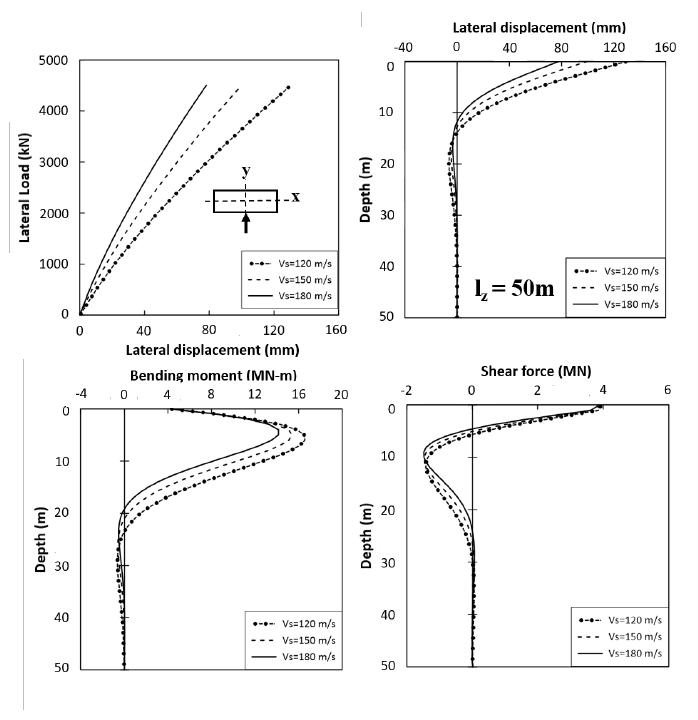
Fig. 7. Performance of 50m barrette in sand with load applied in transverse direction